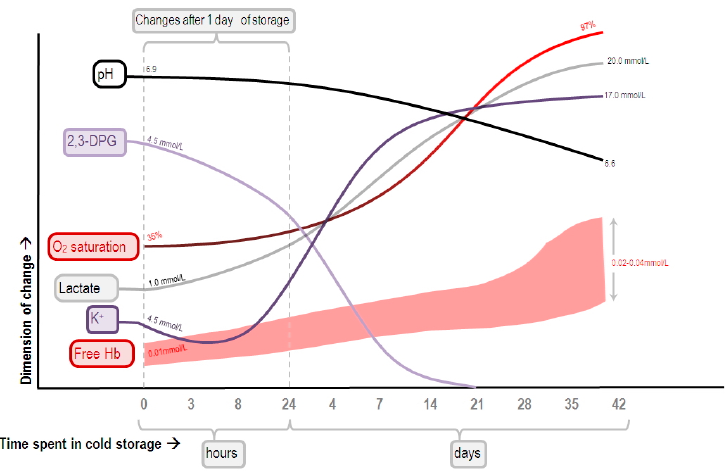
Figure 2. Schematic representation of the changes of pH, and the concentrations of 2,3-diphosphoglycerate (2,3-DPG), lactate, potassium, and free hemoglobin (Hb) in stored red blood cells. Figure adapted from [49] by Alex Yartsev. Reproduced with permission from Alex Yartsev, Deranged Physiology website (http://www.derangedphysiology.com), accessed on 29 May 2017.